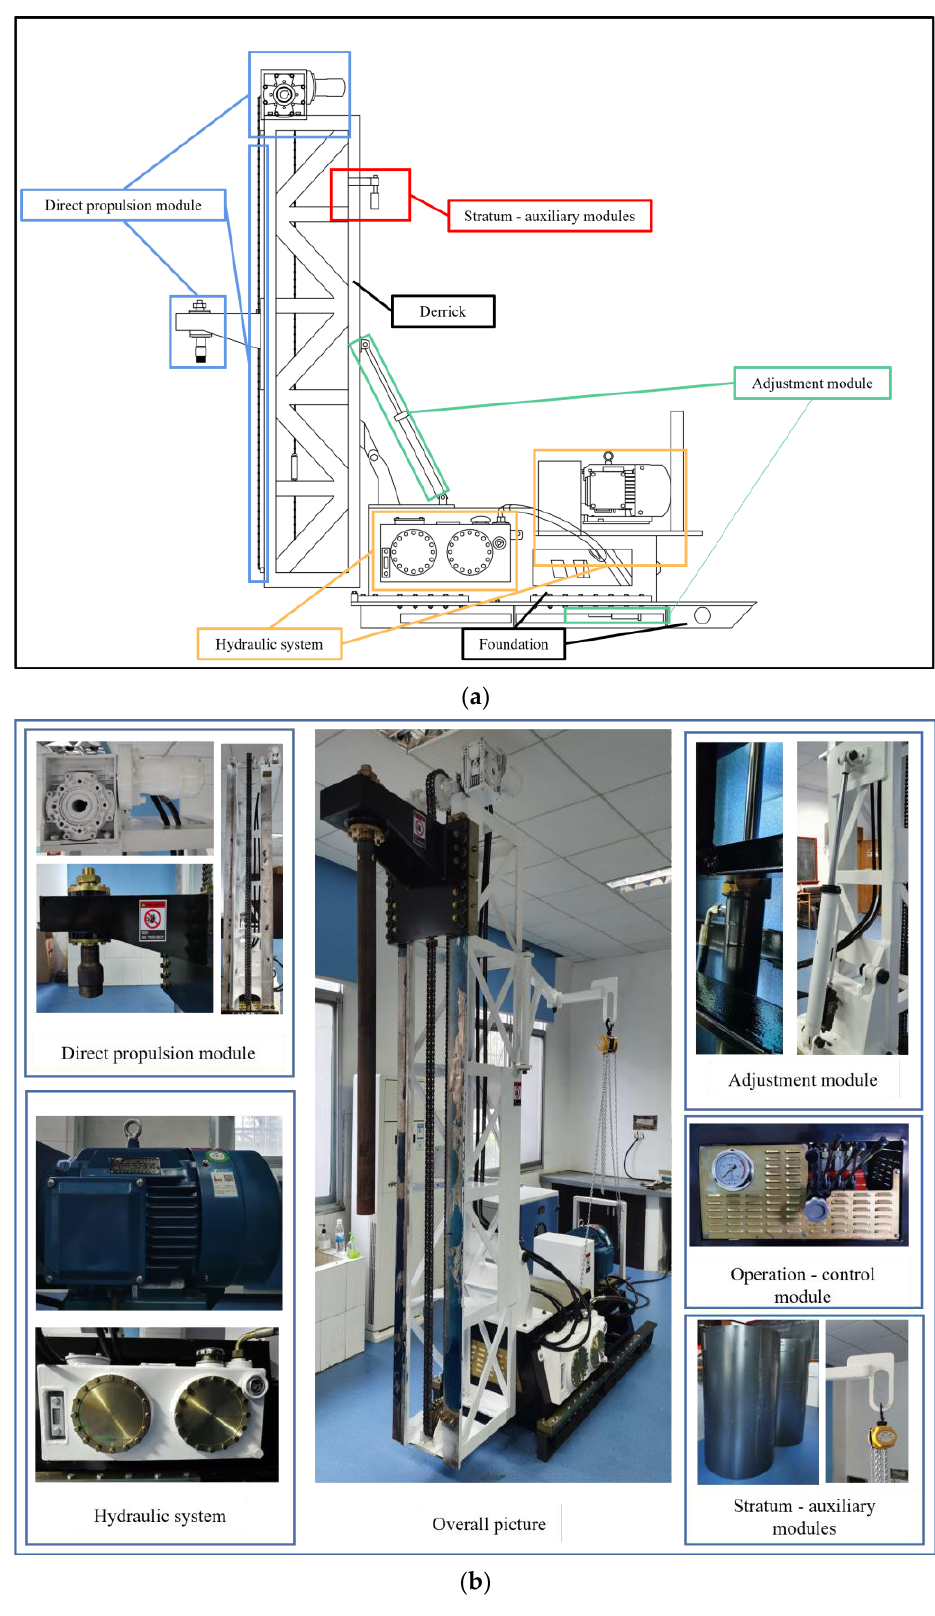
Figure 3. Overall design and physical drawing of the C-DP drilling rig. ( a ) Model drawing; ( b ) Physi- cal